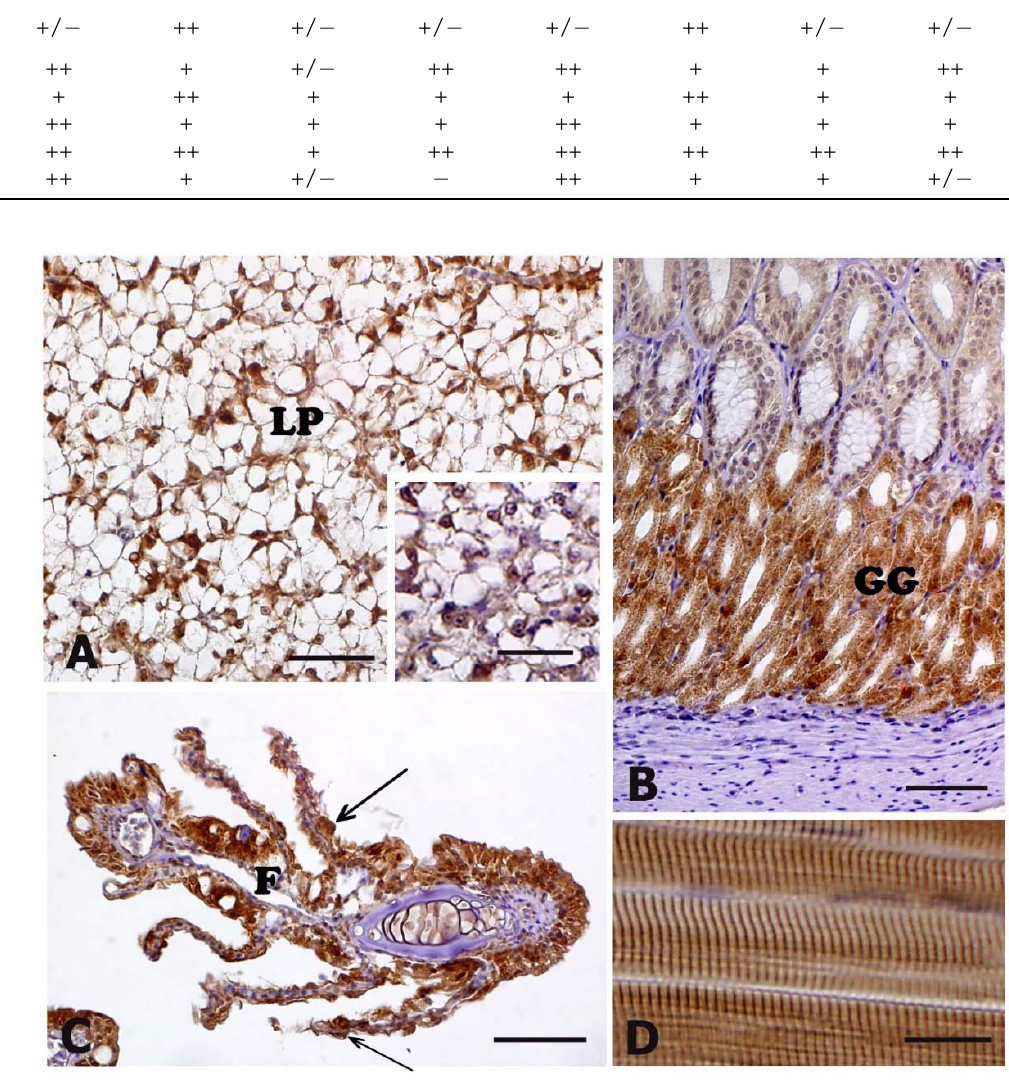
Figure 3. Heat shock protein 70 (HSP70) immunohistochemical localization in meagre ( Argyrosomus regius ). Panel ( A ) represents a control animal; insert in ( A ) and panels ( B – D ) represent animals exposed to transport stress. All panels are counterstained with Mayer’s haematoxylin. No differences in term of immunoreactivity were observed between control and transported animals (see also Table 2). (A) In liver, HSP70-immunostaining is present in the parenchyma (LP), at the level of the cytoplasm of hepatocytes. (B) In the stomach, immunopositivity is present in the gastric glands (GG). (C) The epithelial cells lining both filaments (F) and lamellae (arrows) show a marked HSP-70 bars: (A–C) 20 µ M; (D) 10 µ M; insert in (A) 20 µ